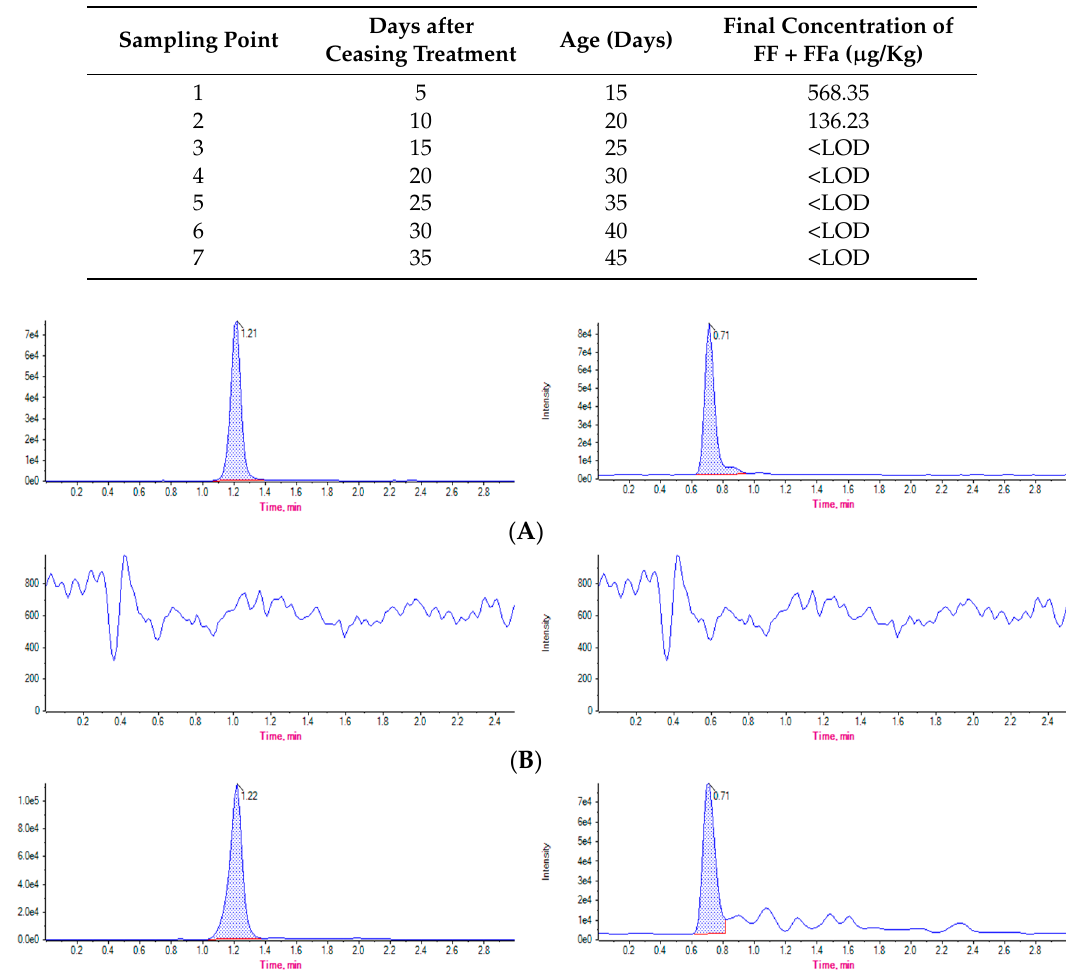
Table 2. FF and FFa residue concentrations in chicken broiler droppings after treatment with a commercial formulation, by sampling point.